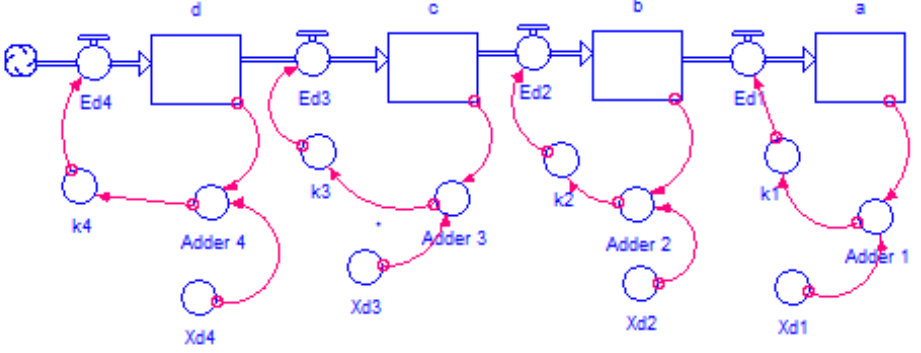
Figure 19. Forrester diagram for the cutting process with n = 4.